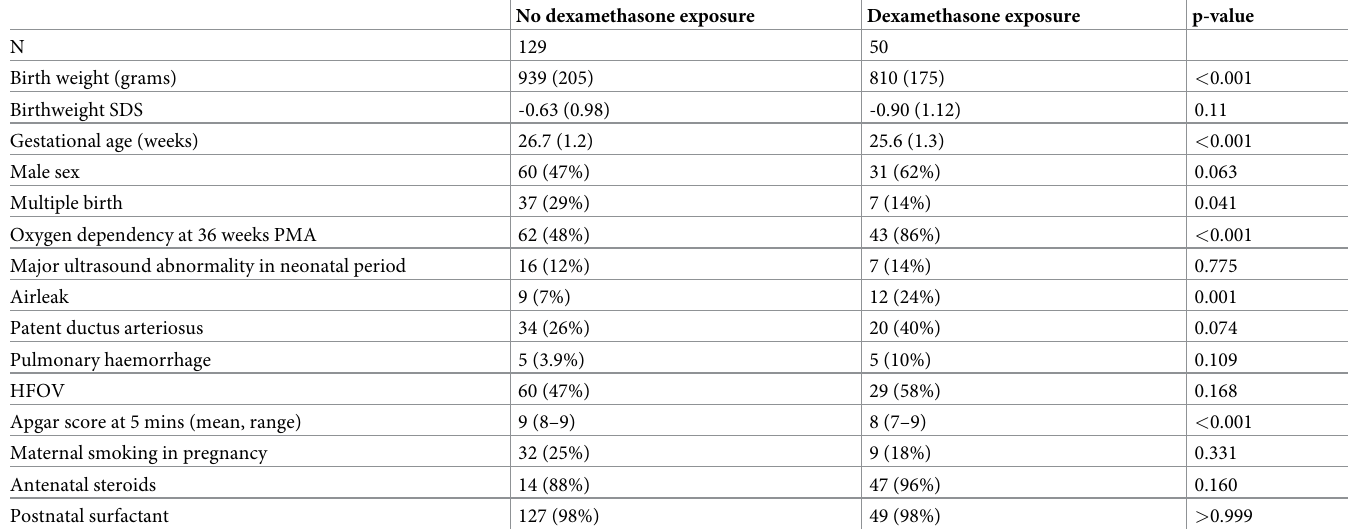
Table 1. Characteristics of children who were or were not exposed to dexamethasone. The data are presented as the mean (SD) or n (%) unless otherwise shown.